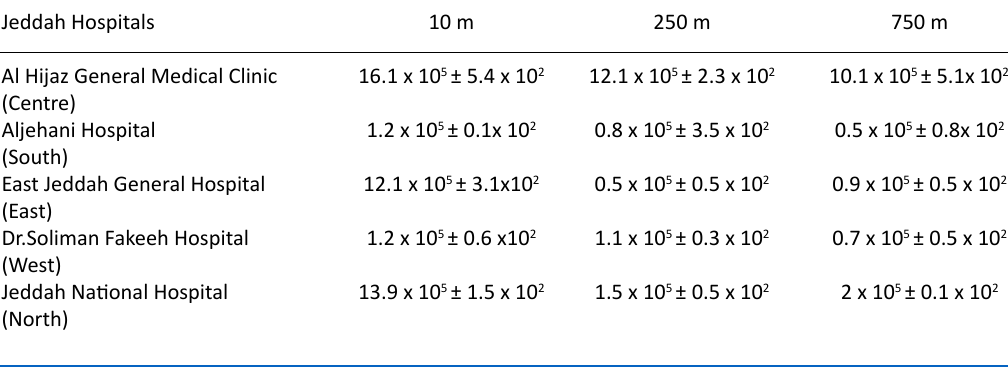
Table 1. Existence of MRSA in soils nearby the hospitals in Jeddah Jeddah